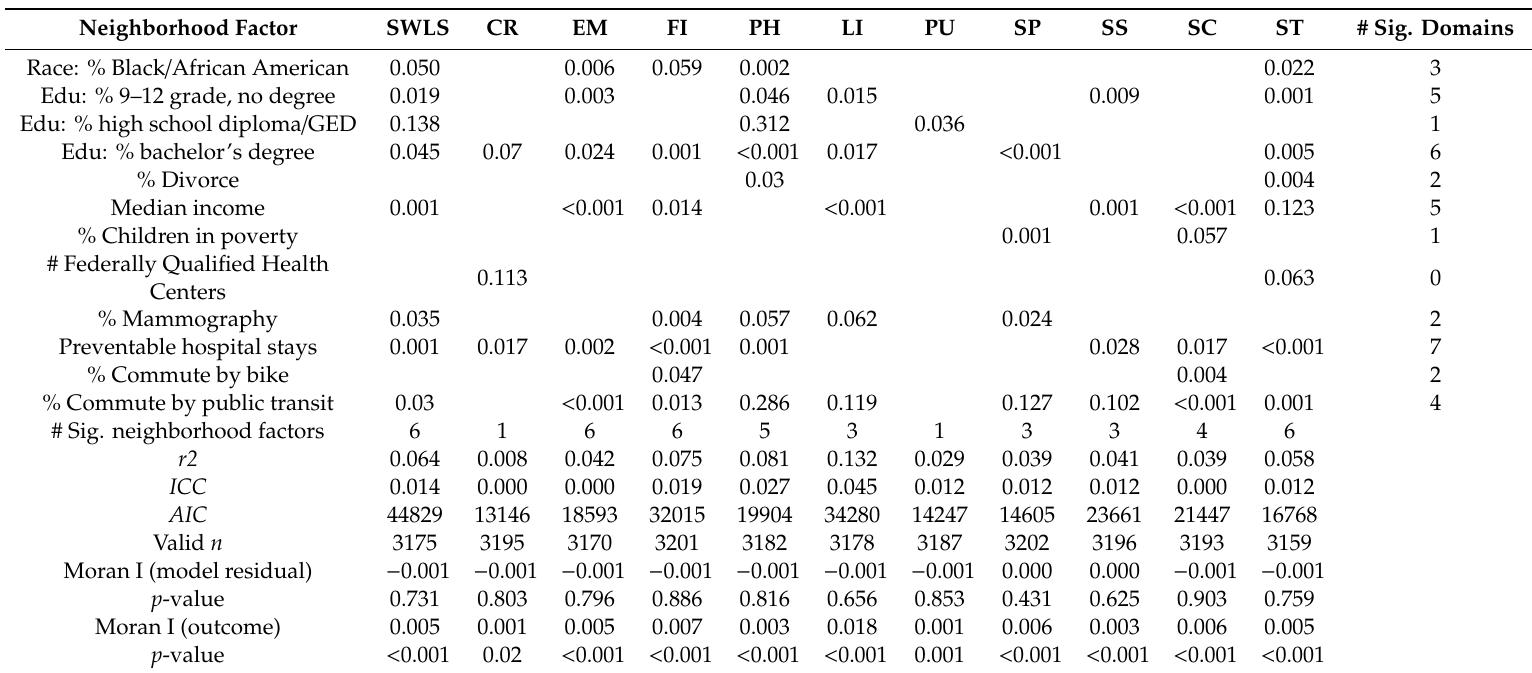
Table 5. Significant di ff erences in well-being outcomes between neighborhood factor quantile groups (determined by Type II sums of squares tests for ANOVA e ff ects, reported as p -values).